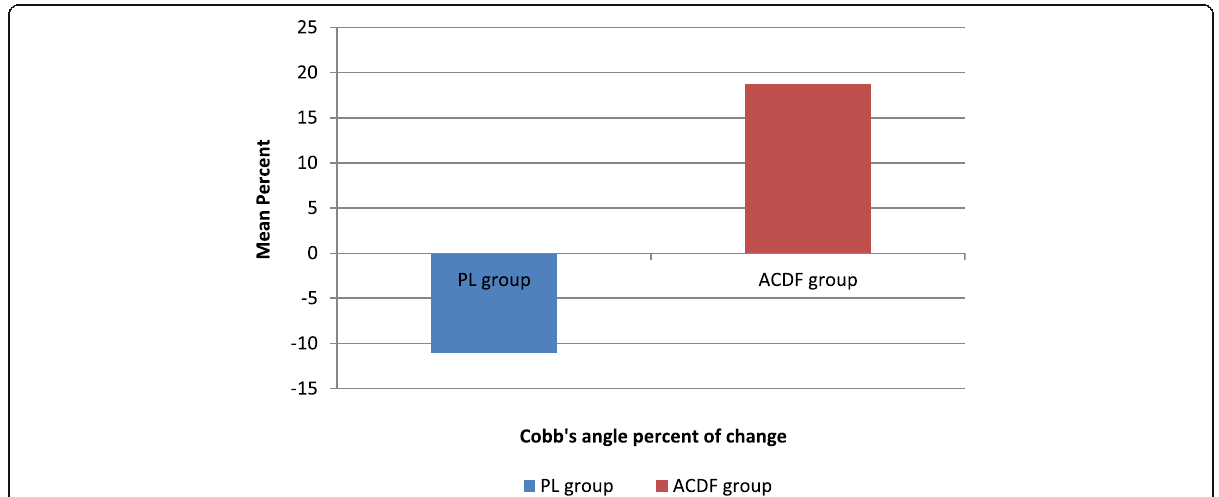
Fig. 4 Cobb ’ s angle percent of change in mean value following surgery in both groups